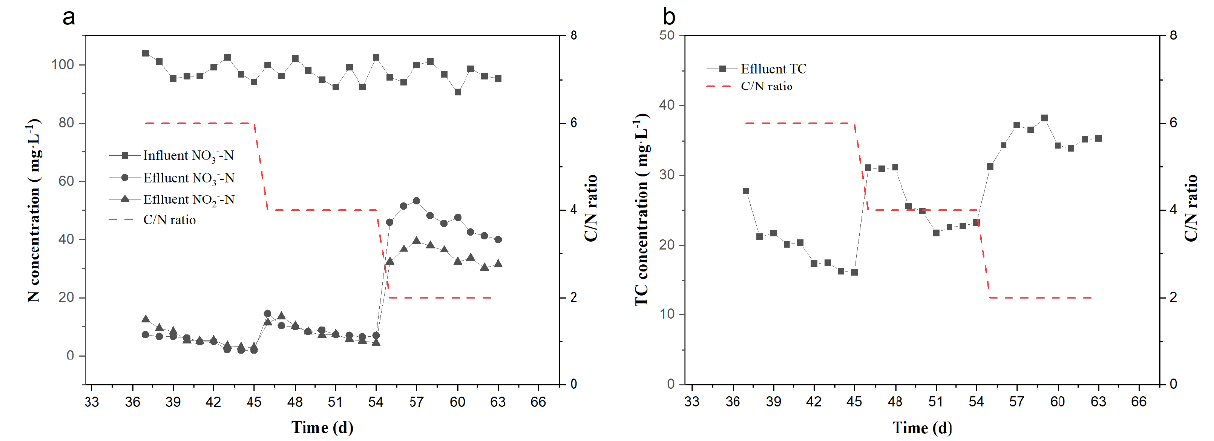
Figure 3. ( a ) Denitrification performance and ( b ) TC removal under different C/N